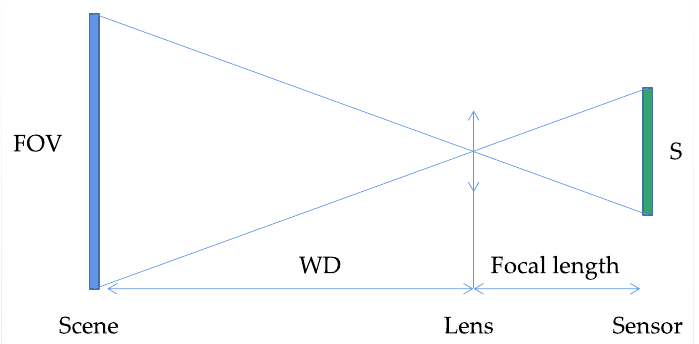
Figure 4. Illustrations for conversion coefficient determination.